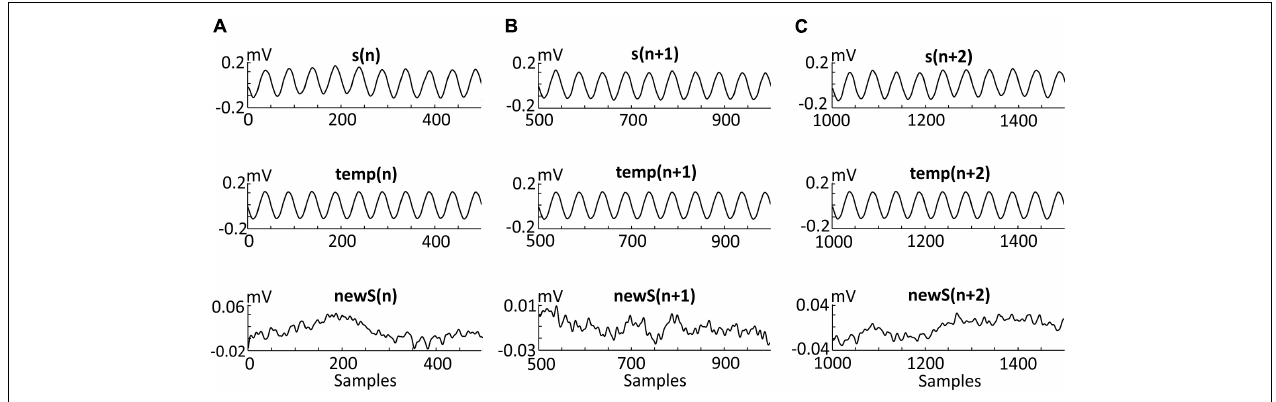
FIGURE 5 | Effects of the three steps of the algorithm. Three adjacent segments [s(n) (A) , s(n + 1) (B) , and s(n + 2) (C) ] recorded during the stimulation of the second participant (details provided in the “Methods and Materials” section). Each segment contains 10 oscillations of a 10 Hz alternating current. Thus, each segment is a 1-s recording and, due to the 500 Hz sample frequency, every s(n) contains 500 samples. Of note, one period contains 50 samples according to the simple calculation (500 Hz)/(10 Hz) = 50. Each template [i.e., temp (n), temp(n + 1), and temp(n + 2)] was created by averaging 20 segments centered around segments s(n), s(n + 1), and s(n + 2). Three new segments [i.e., newS(n), newS(n + 1), and newS(n + 2)] were obtained after subtracting the artifact templates as follow: s(n)-temp(n) =